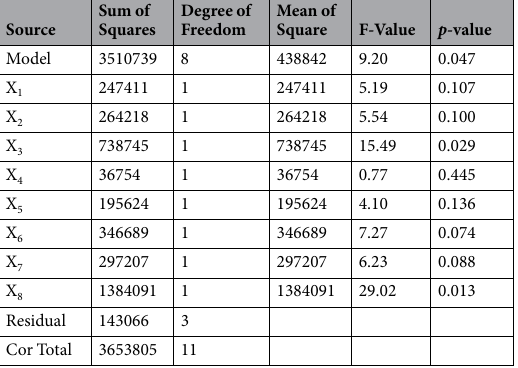
K 2 HPO 4 (X 3 ) (g/l)